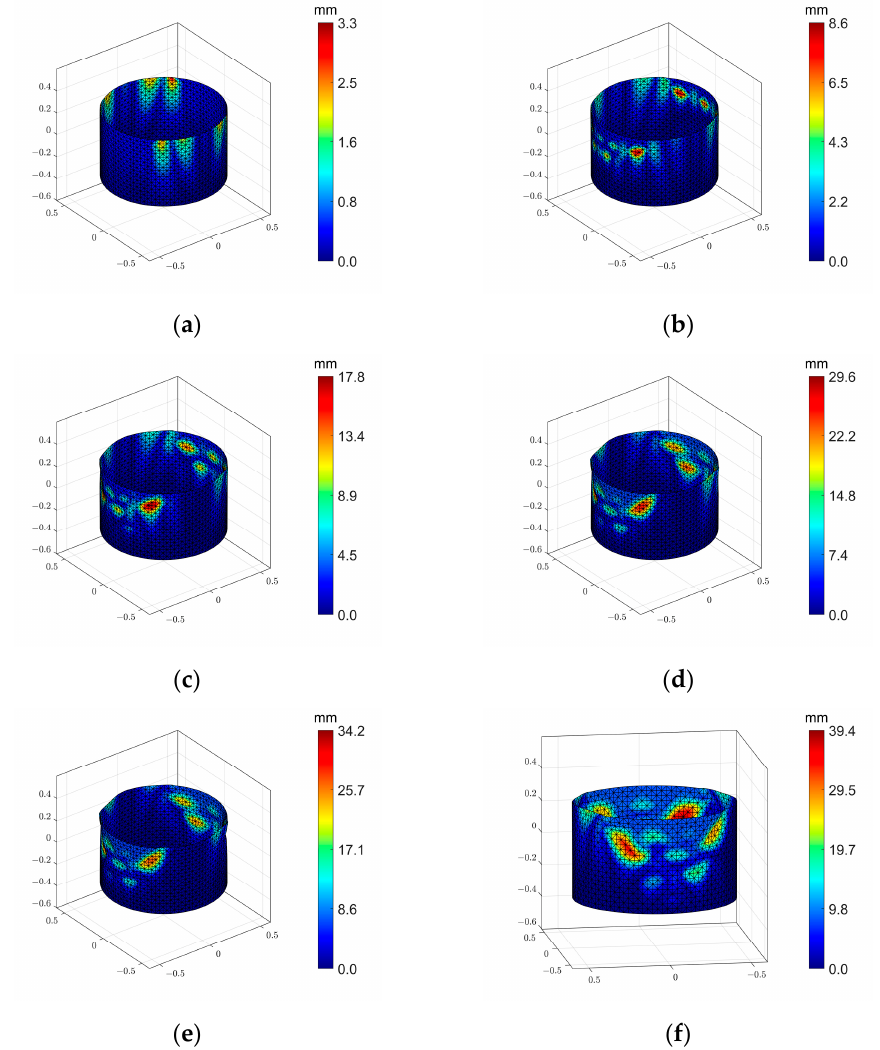
Figure 9. Postbuckling of 2 × 90° local axial compression: ( a ) before buckling, ( b , c ) first buckling, ( d – f ) second buckling.